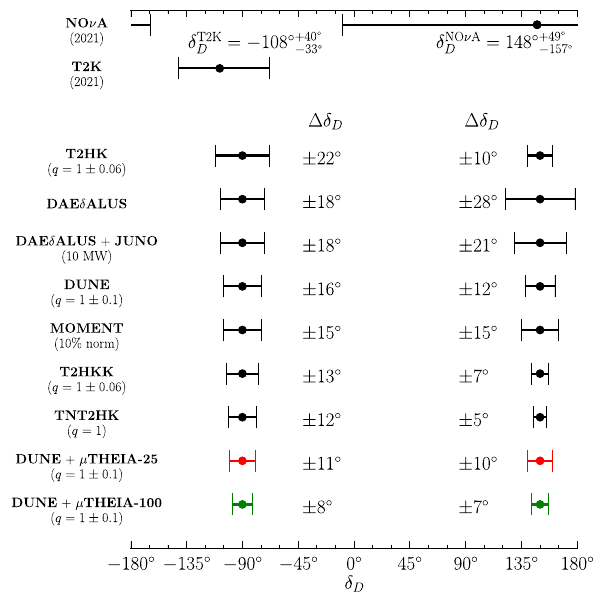
Fig. 16 The current δ D measurement at T2K and NO ν A. For com- parison, the projected CP sensitivities at various future and planned experiments are sorted by the size of CP uncertainty. For T2K and NO ν A that are already running, their latest results from real experi- mental data are shown while for those still in plan or design, we simply quite the CP uncertainty at two typical CP phase values δ D = − 90 ◦ and 150 ◦ for illustration. These experiments are sorted according to their uncertainties around δ D = − 90